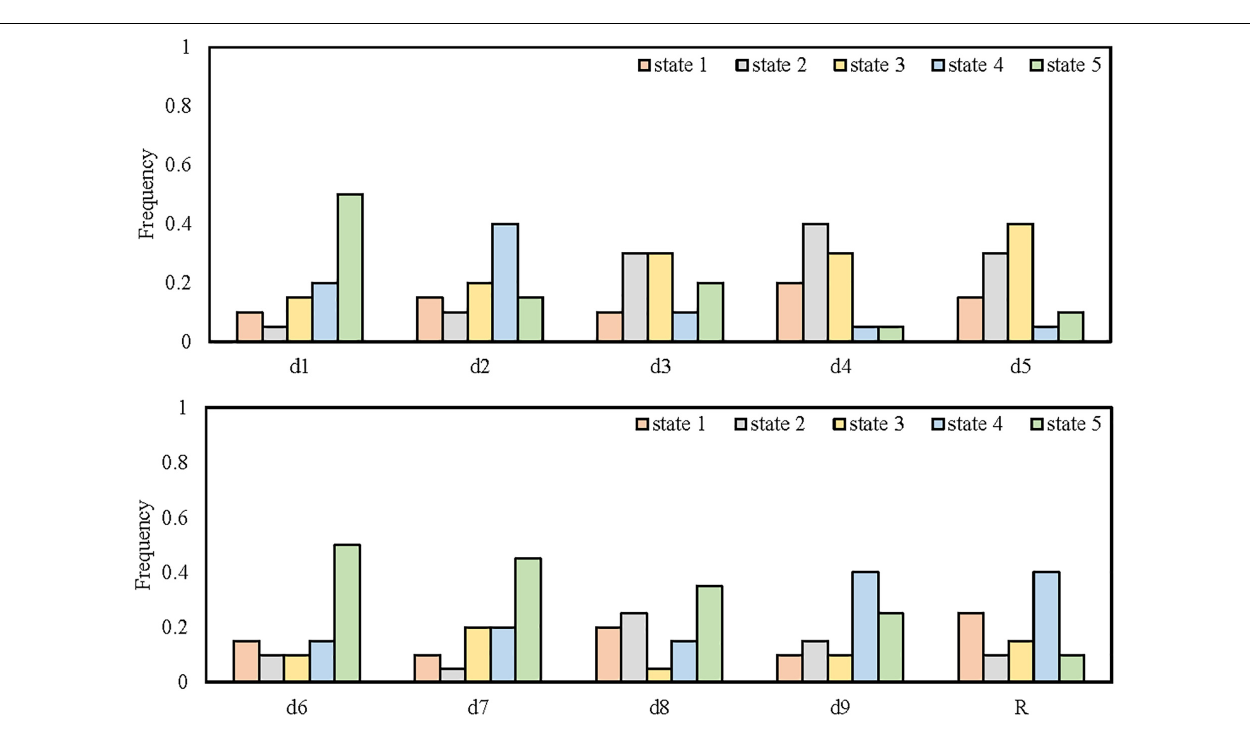
FIGURE 4 | Frequency distribution of all states of each